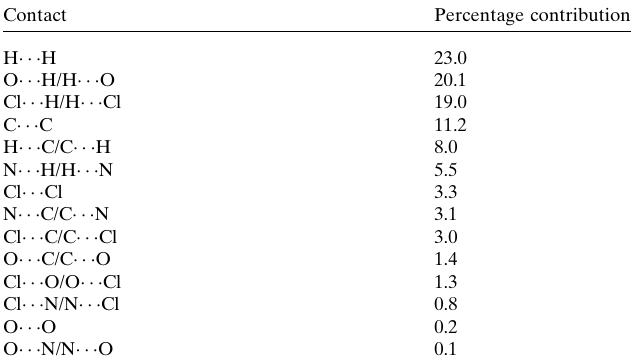
Table 3 Percentage contributions of interatomic contacts to the Hirshfeld surface for the title compound.